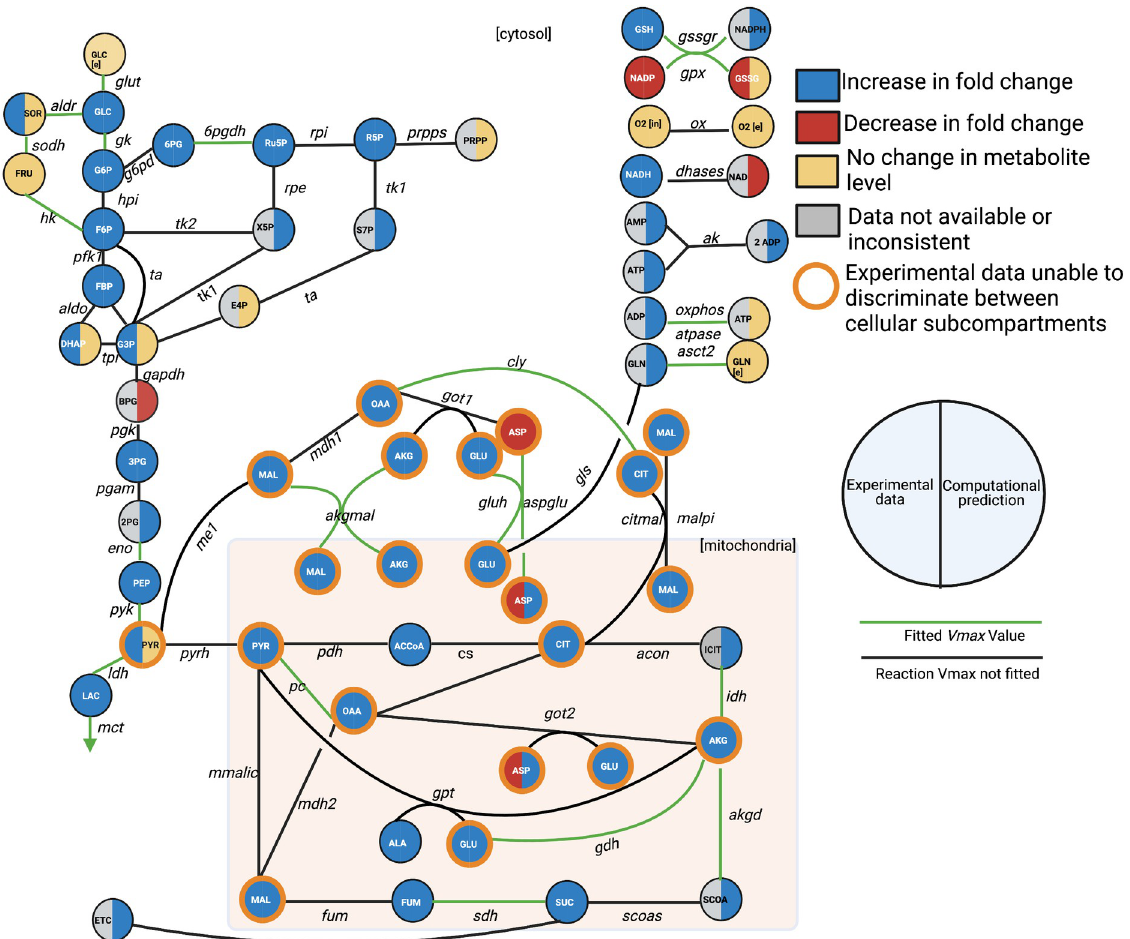
Fig 1. Metabolic network. The network of pancreatic beta cell central metabolism consists of 56 metabolites connected via 65 enzyme- catalyzed reactions, making up glycolysis, glutaminolysis, PPP, TCA Cycle, polyol pathway, the electron transport chain, and shuttles between the cytoplasm and mitochondria (denoted by the shaded rectangle). For clarity, some metabolites are shown as multiple nodes within a subcompartment (for example, mitochondrial AKG is shown as two nodes, though they represent the same metabolic species). As part of model training, we performed a sensitivity analysis, and the reactions whose V max values were significantly impactful are colored green. We compared model predictions of metabolite levels after 60 minutes of stimulation with 2.8 mM glucose, relative to metabolite levels following 60 minutes of stimulation with 16.7 mM, to qualitative shifts in metabolism as reported in the literature, provided in the supplemental material ( S1 Table ). The experimental observations are indicated by the left half of the metabolite nodes, and the model predictions are shown on the right. The model can differentiate between metabolite location (cytosol versus mitochondria), while the mass spectrometry approaches can only measure the total (pooled) amount of a metabolite; we have outlined those metabolites in orange. The full set of abbreviations and reaction equations is given in S1 Text